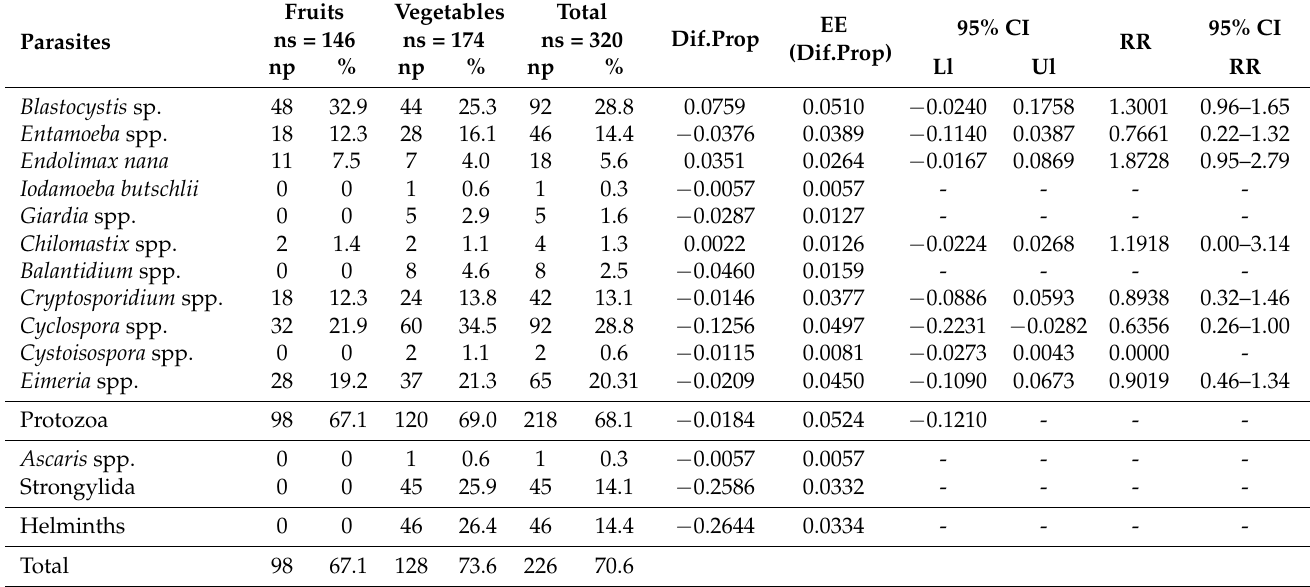
Table 2. Distribution of the frequency of parasite contamination in fruits and